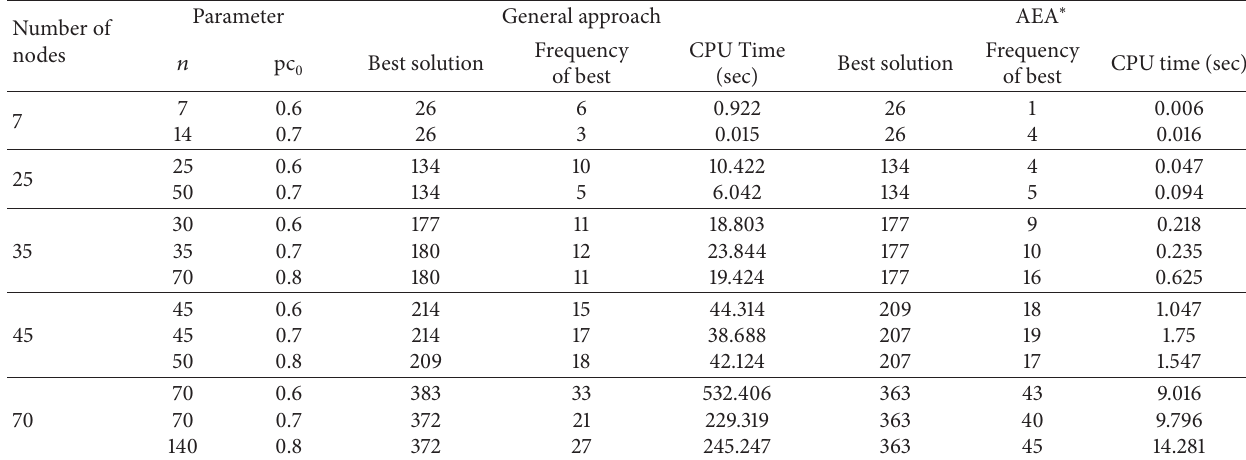
∗ The proposed adaptive evolutionary algorithm.